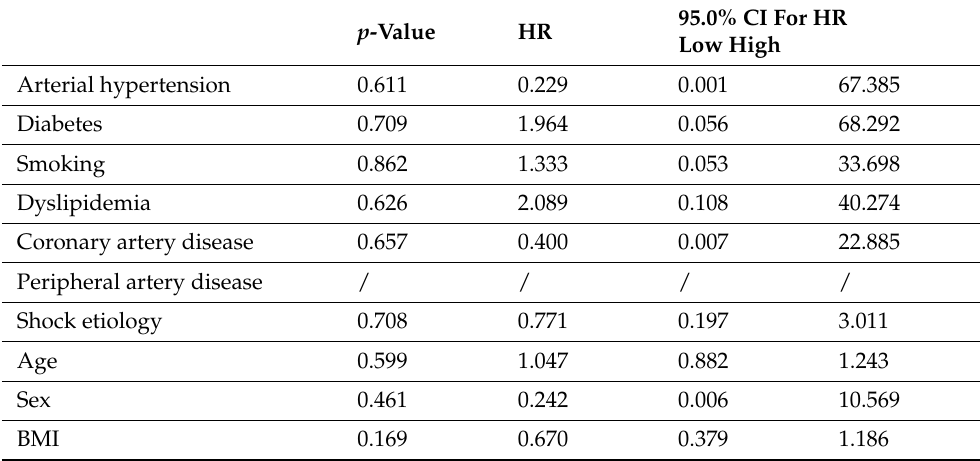
Figure A2. Cox regression curves after hospital discharge between CS and RCA patients. Table A4. Cox regression covariates analysis after hospital discharge.